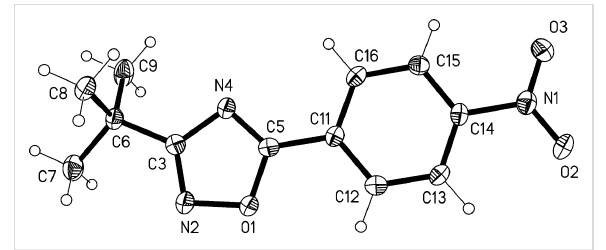
linked to ribbons parallel to the b axis by two C–H···O interac- tions.